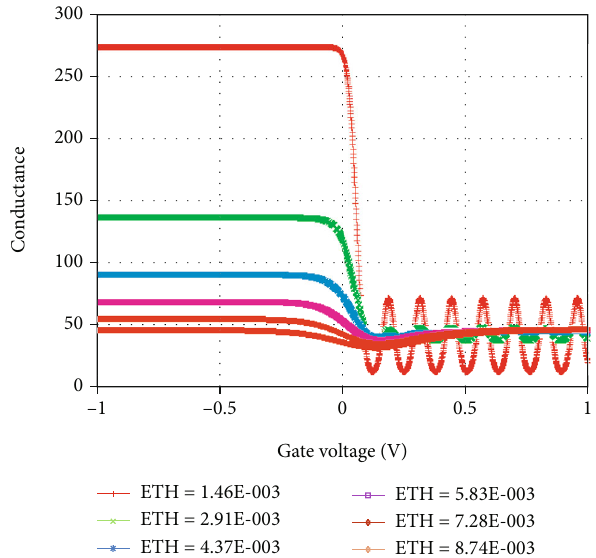
Figure 3: Normalized conductance versus gate voltage when K ≪ Δ E plotted using equation